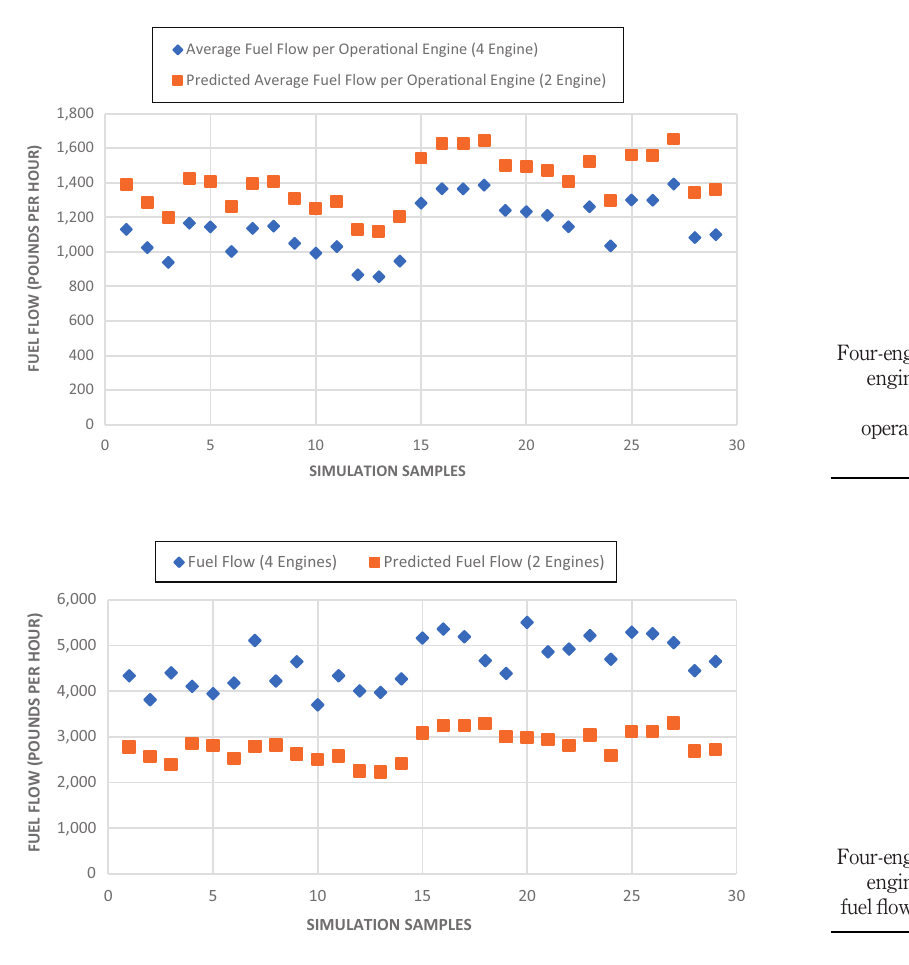
Figure 2. Four-engine and two- engine